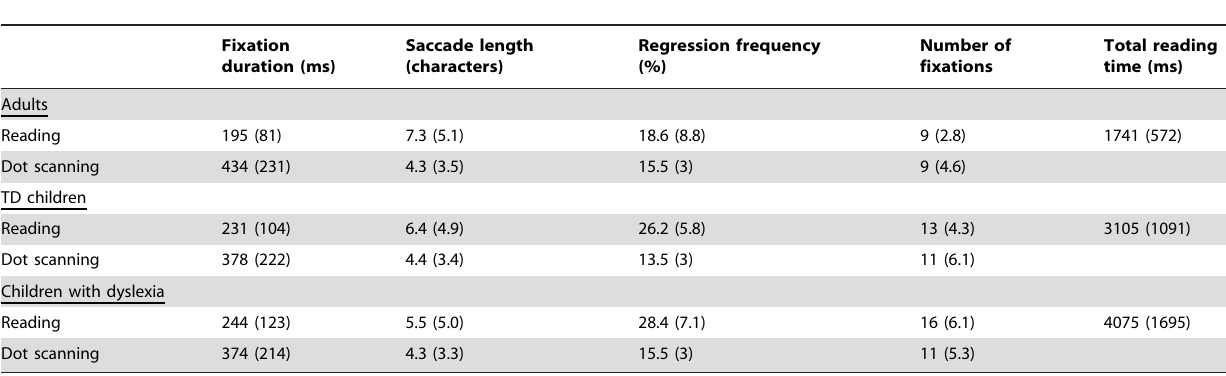
Table 1. Basic characteristics of eye movements during reading and dot scanning: mean fixation durations, saccade length, regression frequency, number of fixations and total reading time (standard deviations in